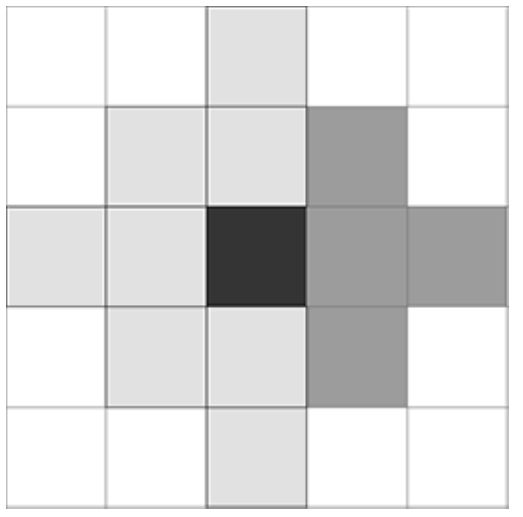
Figure 5: Neighbors given positive bias (middle gray) in easterly wind, fire origin (black), and neighbors given negative bias (light gray)